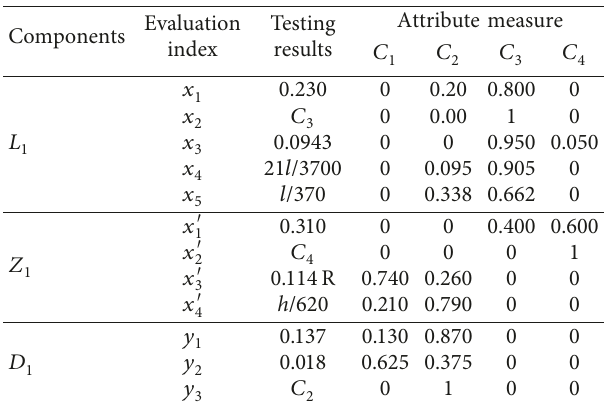
Table 15: Safety evaluation results of components. Component